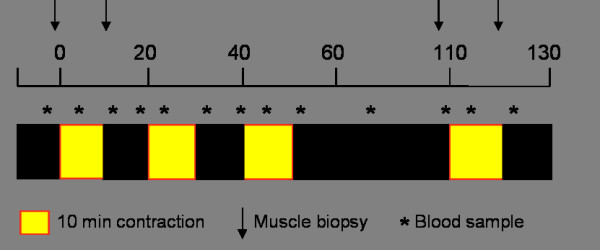
Overview of experimental design.